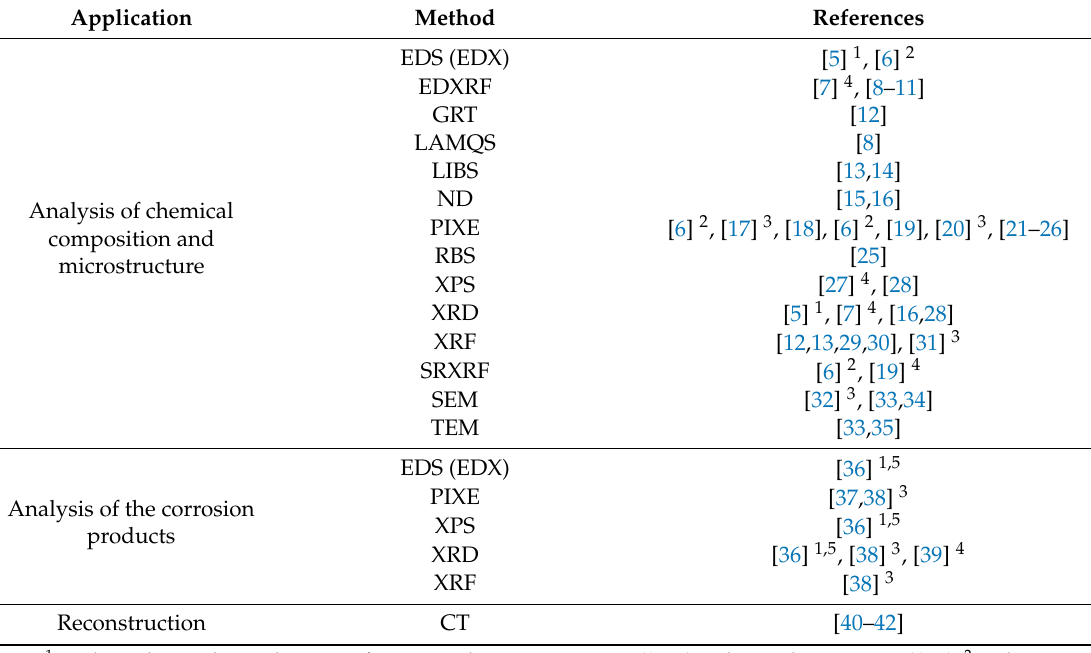
Table 1. Selected X-ray-based methods used for the analysis of ancient